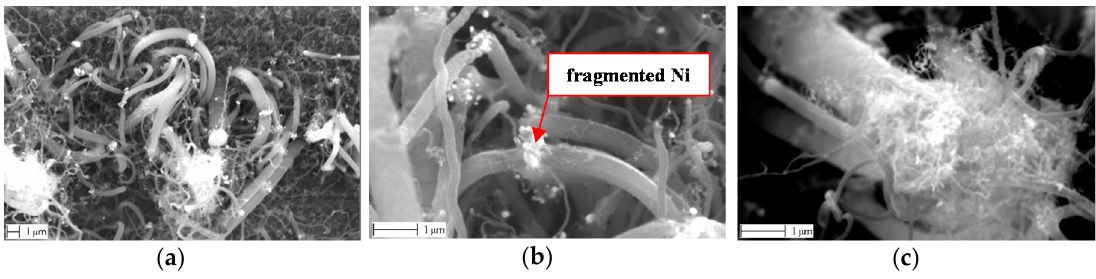
Figure 5. Typical SEM images of CNFs, after acetone solution: overall view ( a ) and larger magnifications ( b , c ).